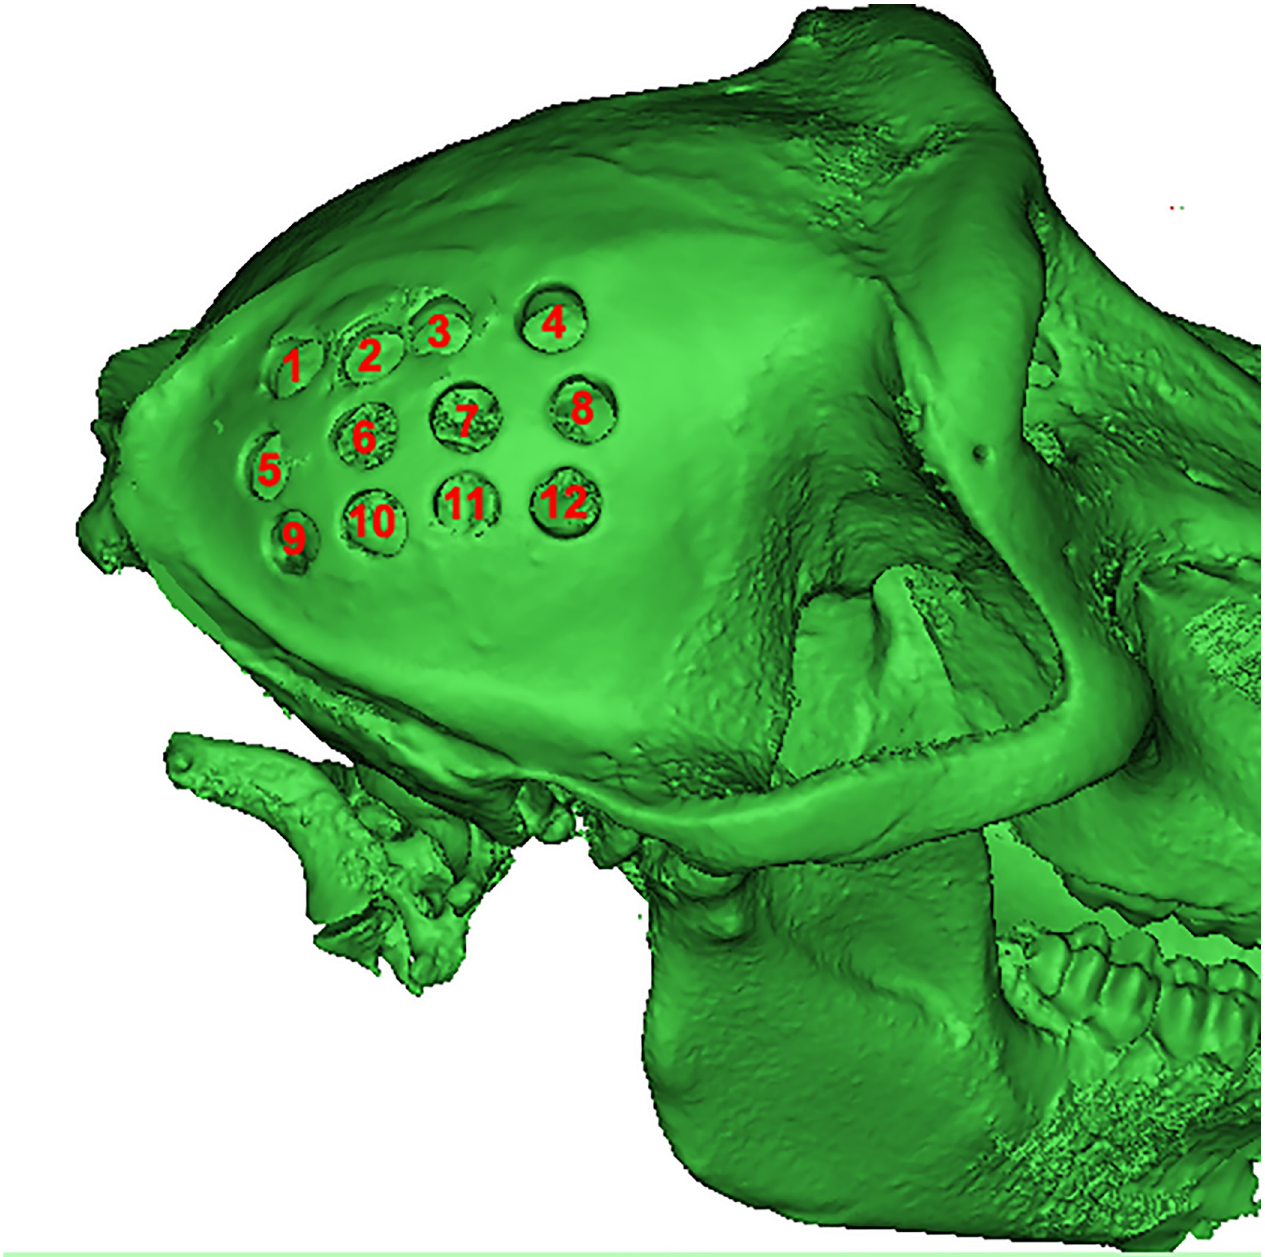
Fig 1. Location of the sampling sites on the right parietal